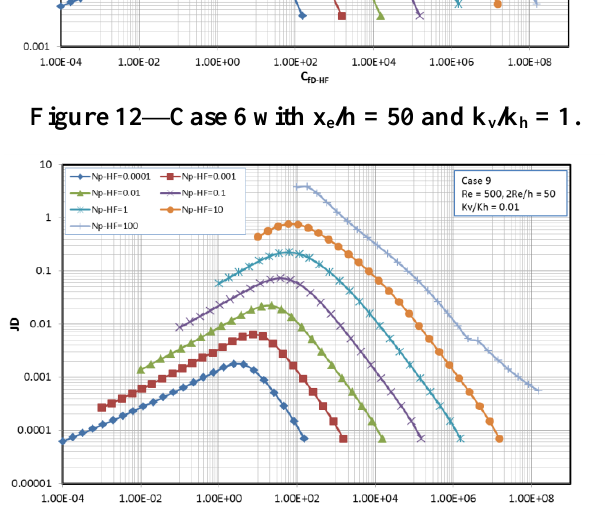
Figure 13—Case 8 with x